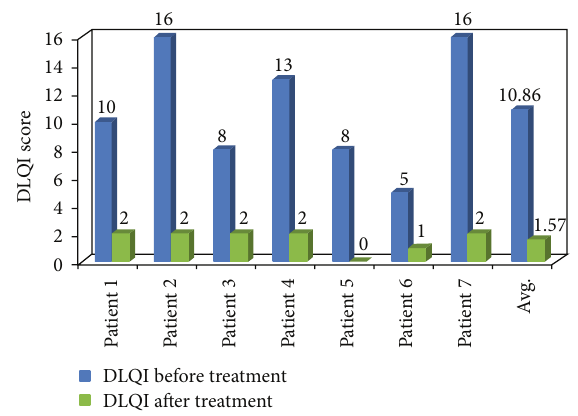
Figure 2: Effect of Itolizumab treatments on DLQI score of